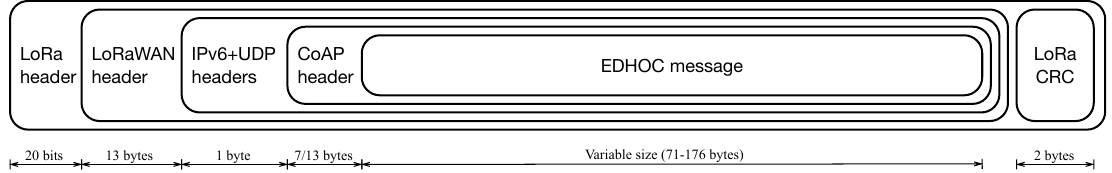
Figure 5. LoRa frame finally created to transport EDHOC